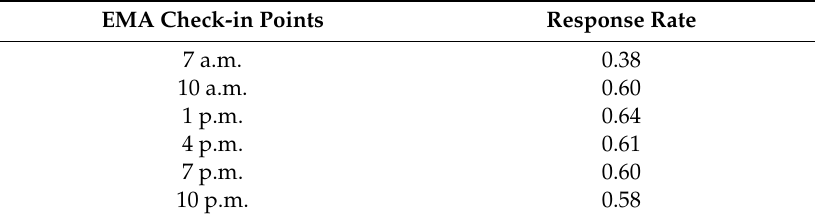
Table 3. EMA response rates.